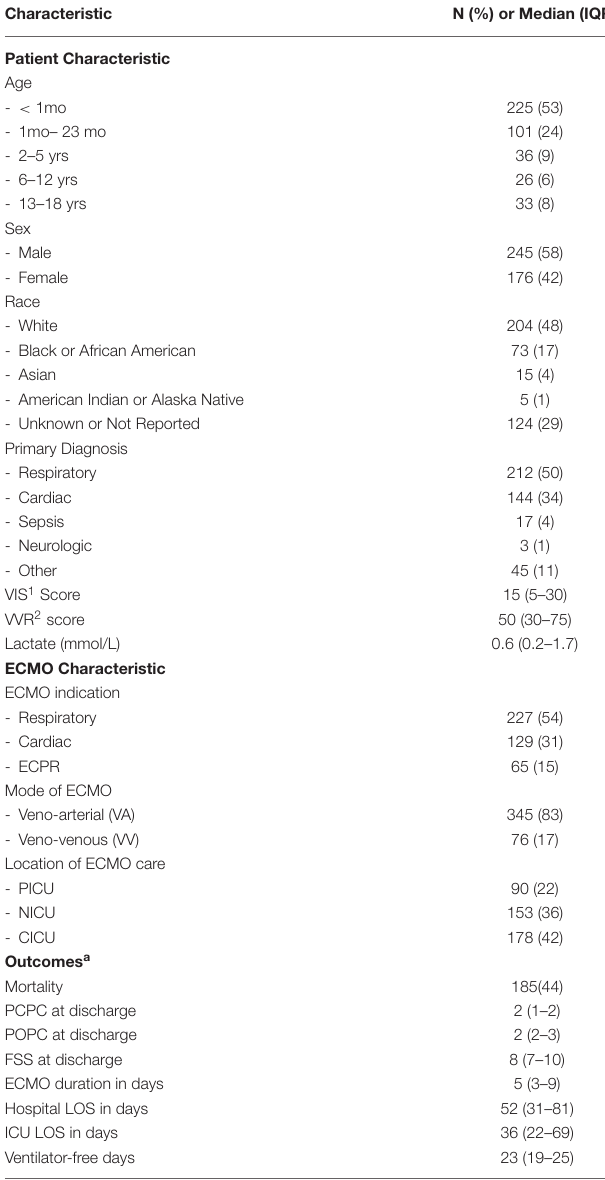
TABLE 1 | Characteristics of Patients and Extracorporeal Membrane Oxygenation